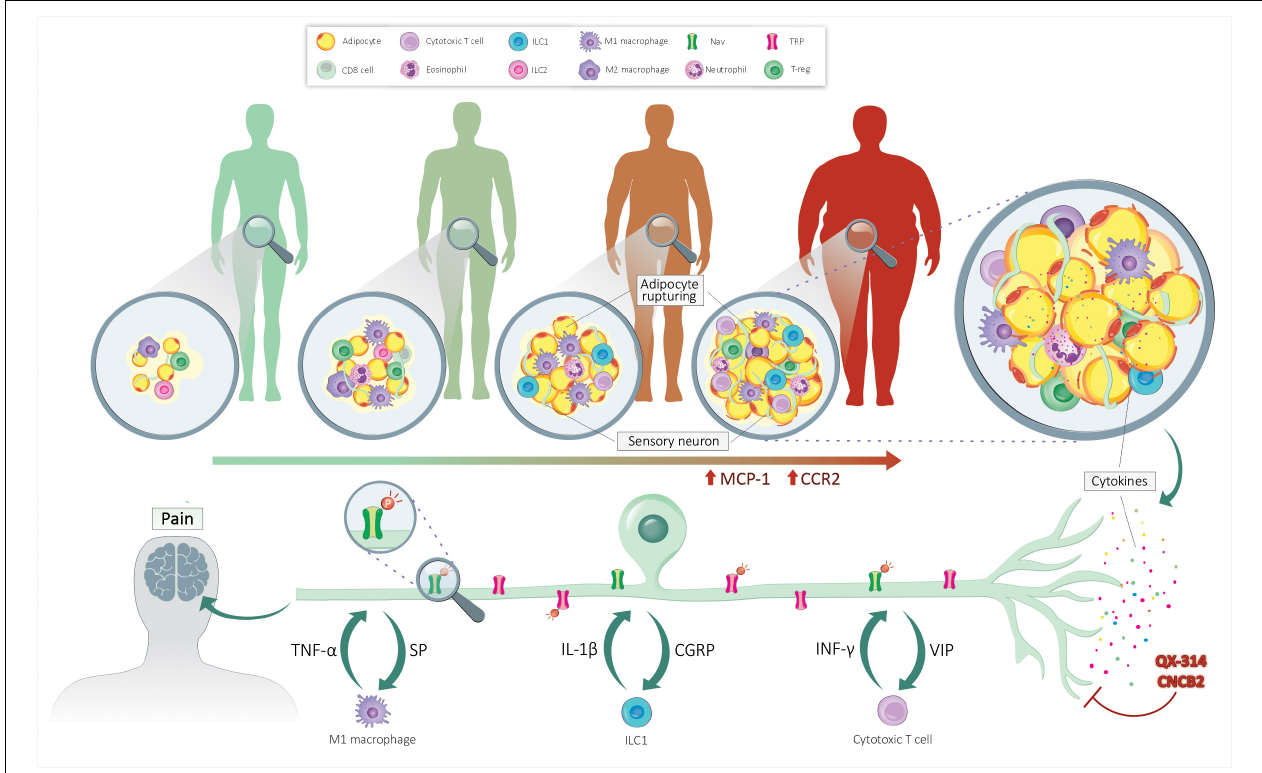
FIGURE 1 | Neuro-immune crosstalk controls obesity-induced pain. Lean individual’s adipose tissue is sparsely innervated and comprises few adipocytes and anti-inflammatory immunocytes. The accumulation of fat leads to the rupture of adipocytes and the secretion of adipokines. These mediators increase the chemotaxis of immune cells, enhancing the level of pro-inflammatory cytokines. By acting on their cognate receptors present on sensory nerves, these cytokines sensitize nociceptor neurons by increasing the expression and phosphorylation of NaV and TRP channels. Upon sensitization, the sensory neurons secrete neuropeptides, further polarizing the fat pad’s immune cells. QX-314 silences nociceptor neuron’s electrical activity, while CNCB2 prevents their release of neuropeptides. By stopping neuro-immune crosstalk, these treatments would help resolve fat pad inflammation and blunt pain